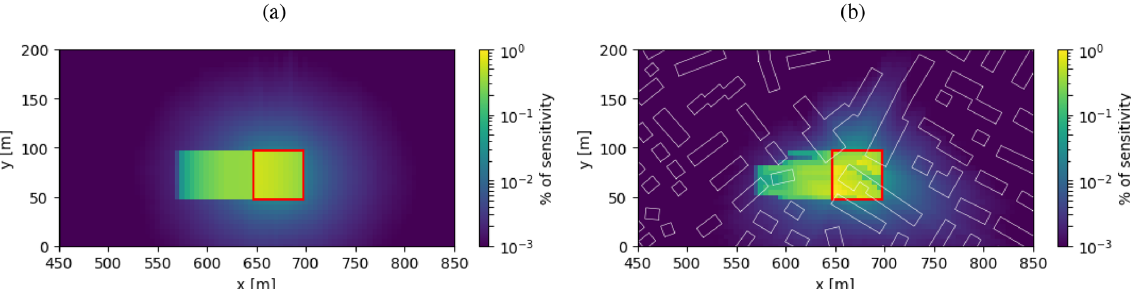
Figure 5. (a) Footprint without buildings; 51.4% of the signal is located outside the ground pixel (i.e., outside the red frame). (b) Footprint with buildings; 52.6% of the instrument sensitivity is located outside the ground pixel. Building contours are in white.